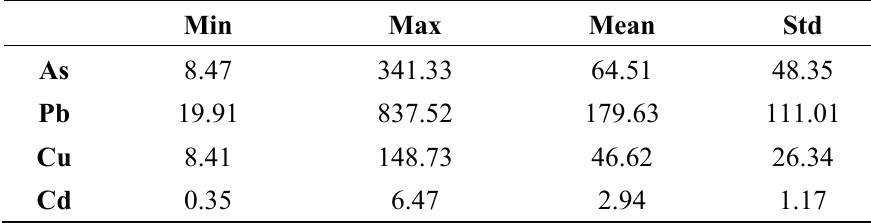
Table 3. Heavy metal concentrations in soil samples. (mg/kg